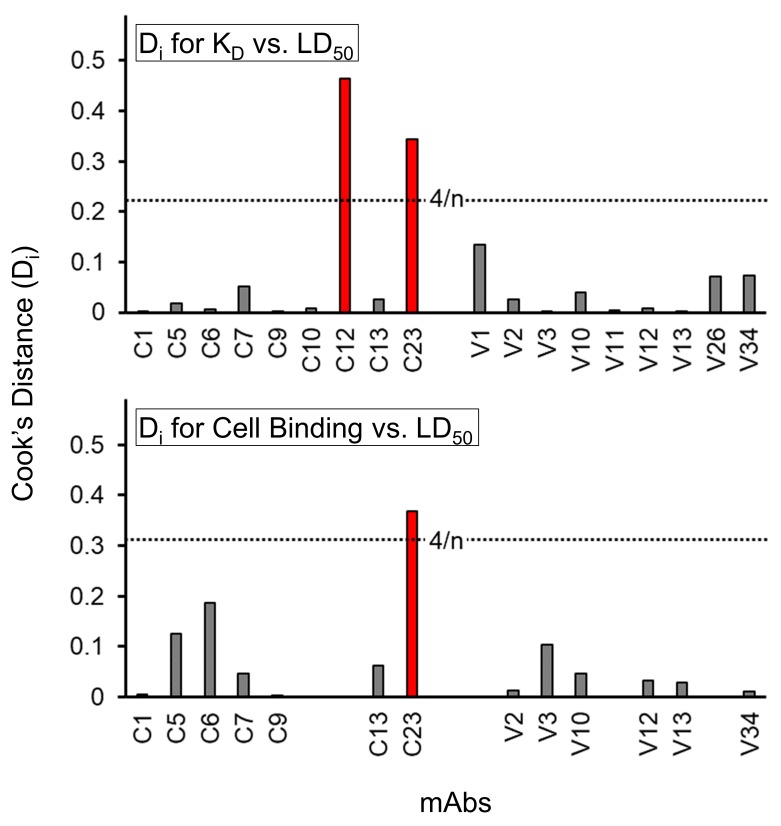
Statistically determined outliers for scatter plots.Cook’s distance (Di) demonstrates the influence of a point on a defined correlation. For the linear correlations of LOG(KD) vs. LD50 (Figure 5D) and FACS Cell Binding vs. LD50 (Figure 5E), Di was determined for each data point. Di values above the threshold of 4/n (red) deviate from the expected relationship between binding and bactericidal activity and were considered to be outliers.